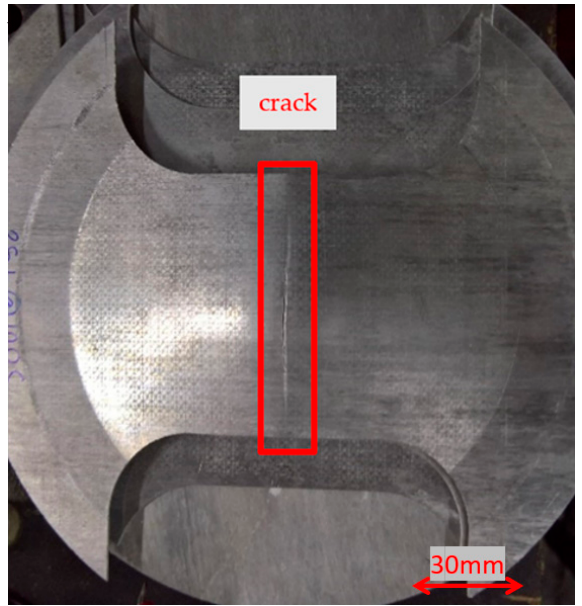
Figure 5. Deformed test pieces of forming limit diagram test. Cracks appear near the apex of the dome.